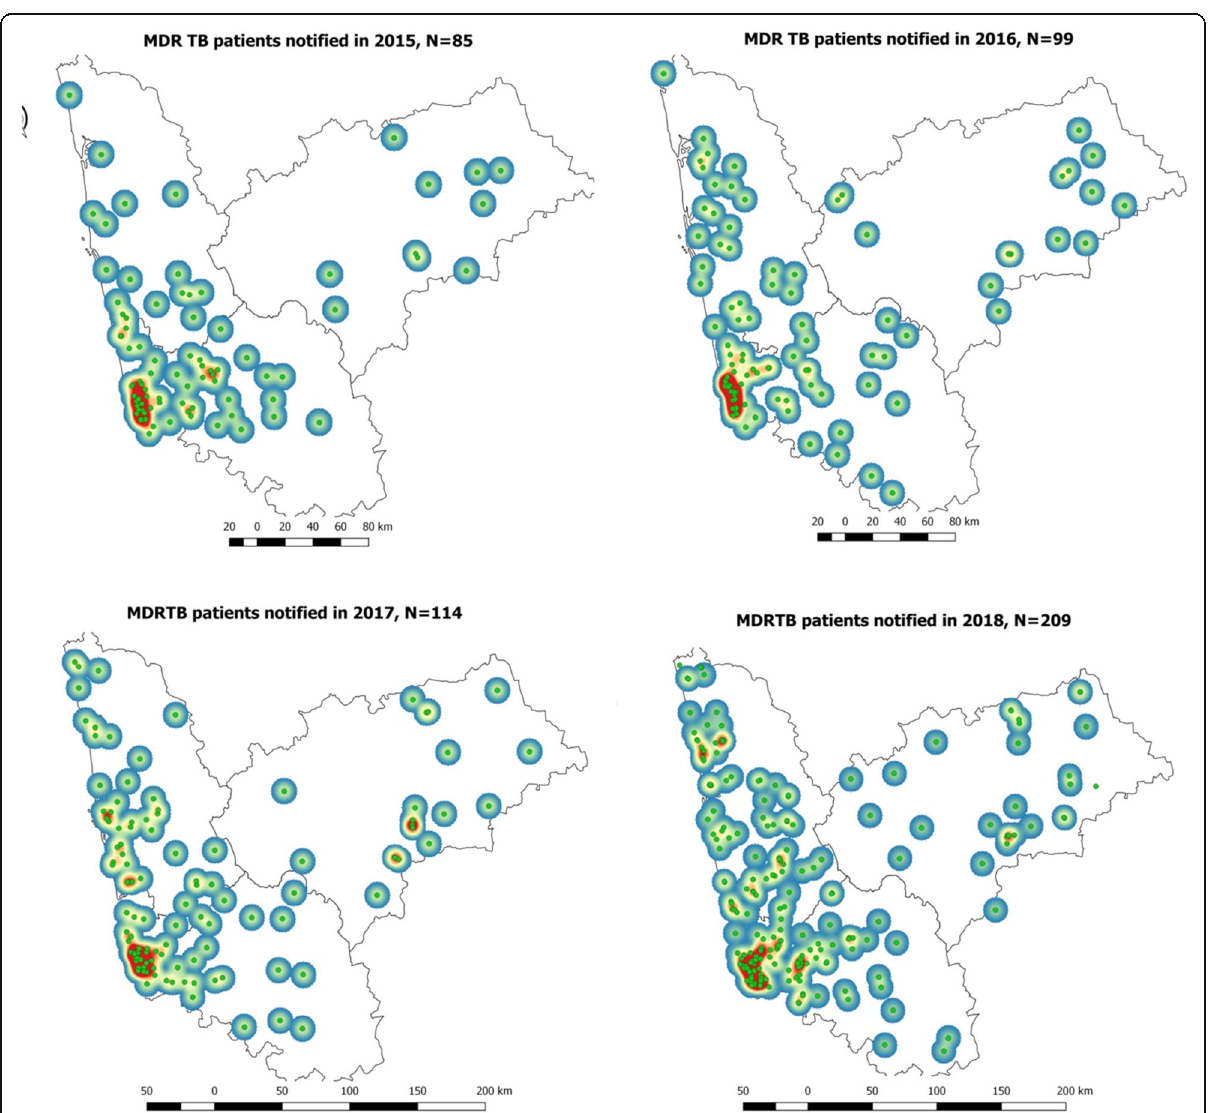
Fig. 3 The heat map of drug-resistant TB patients notified during 2015 to 2018 in three selected districts of Karnataka, South